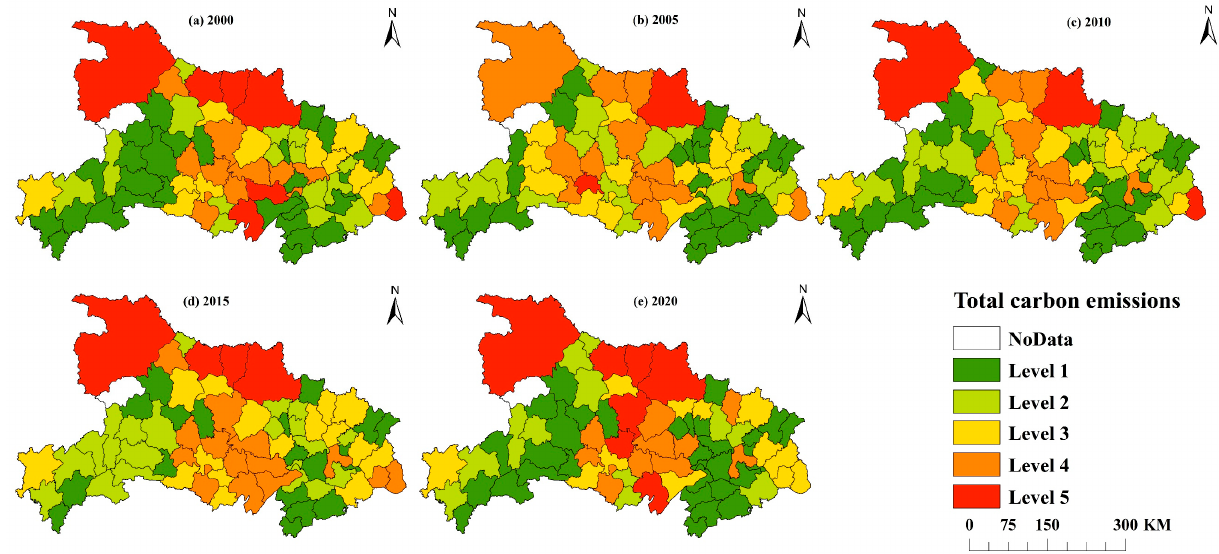
Figure 4. Spatial pattern of carbon emissions in Hubei Province (2000–2020).